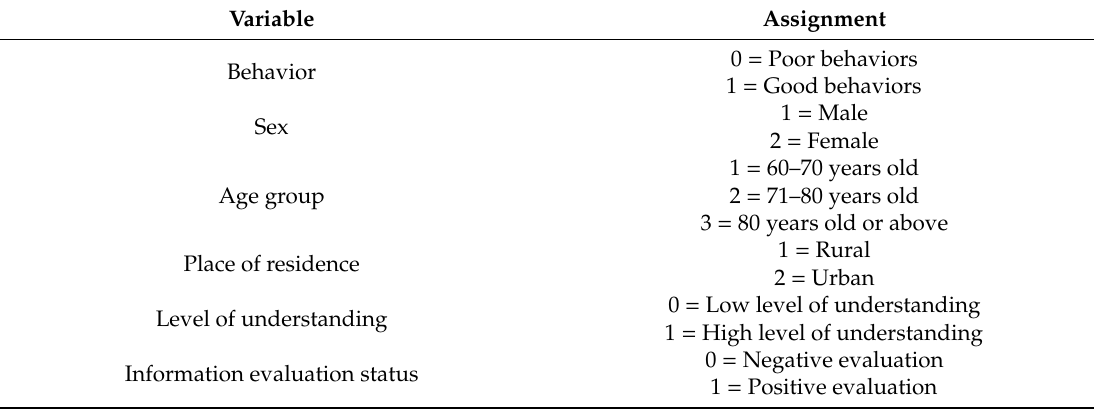
Variable assignment table for COVID-19 protection behaviors based on di ff erent population